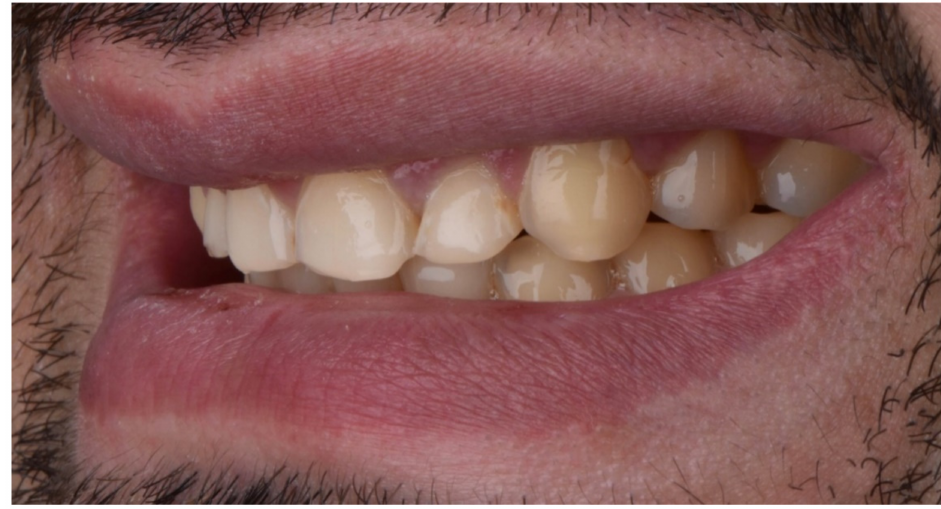
Figure 4. Extraoral smile picture (left).